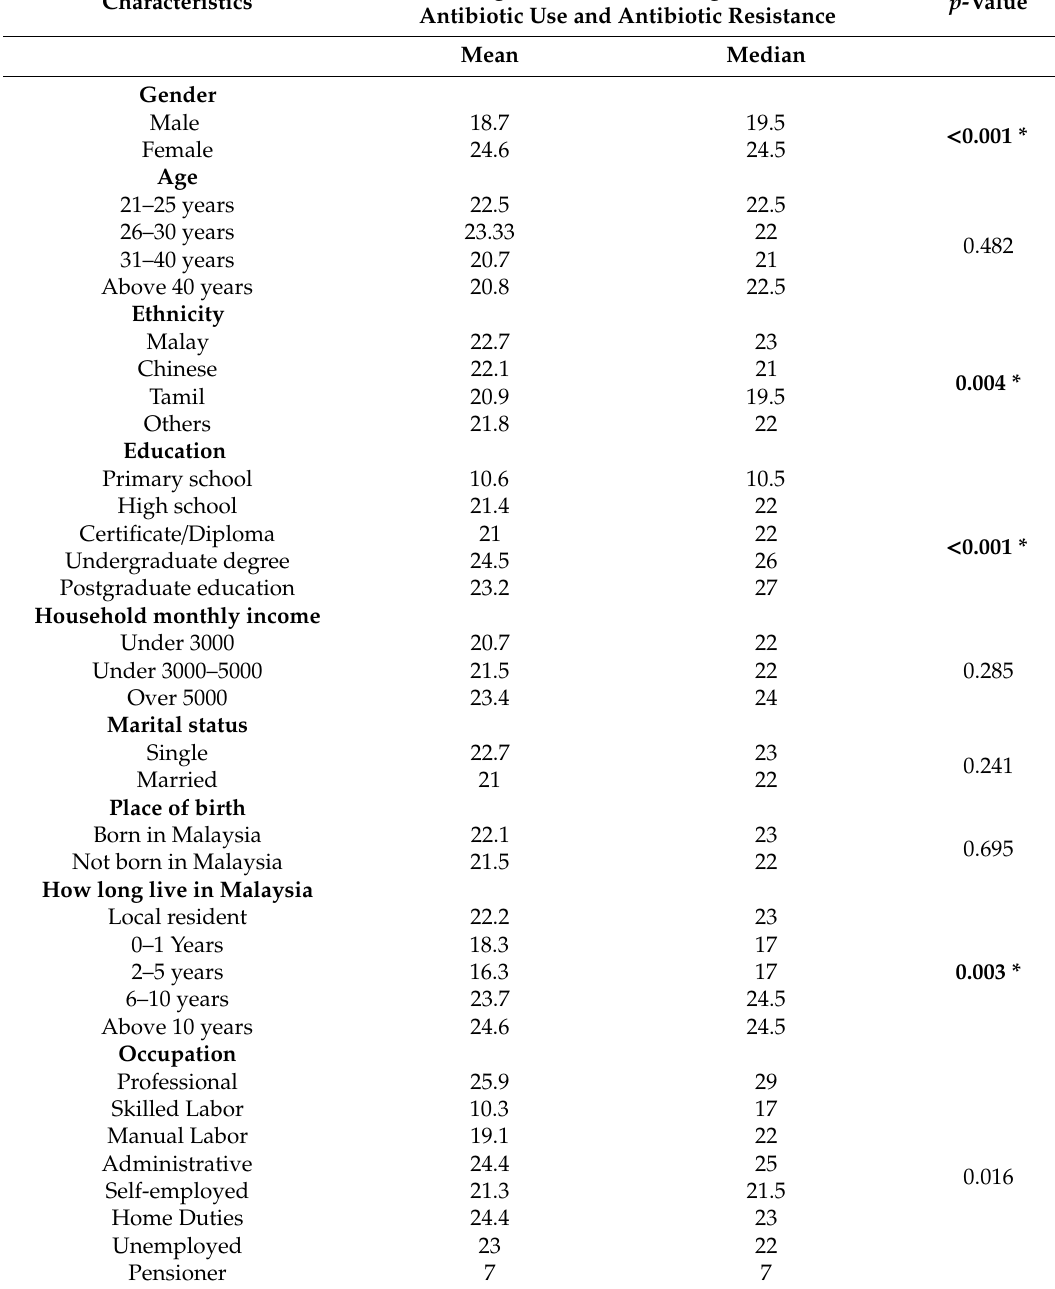
Table 8. Association of demographic characteristics of participants with total level of knowledge and understanding scores about antibiotic use and antibiotic